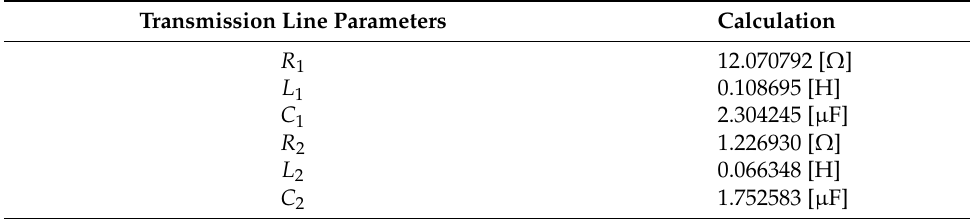
Table 5. Proposed model calculated parameters for Z 11 .